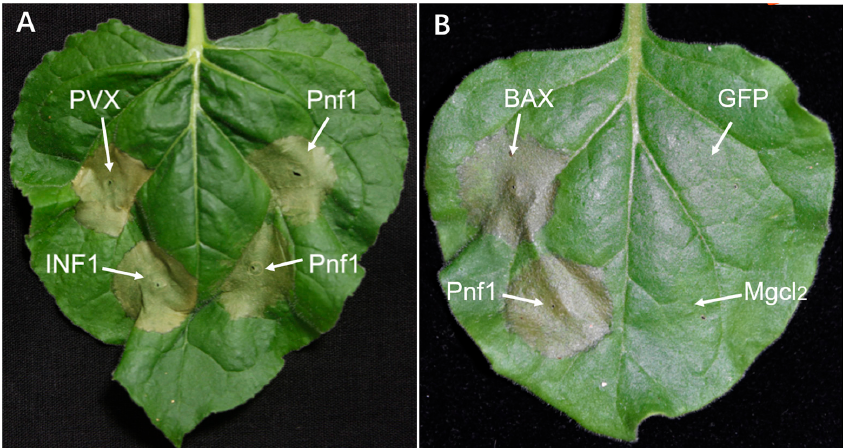
Figure 4. PnF1from Ph. nicotianae JM01 triggers cell death in N. benthamiana leaf. ( A ) The recombinant strains of A. tumefaciens containing PnF1 were infiltrated into N. benthamiana leaf using a needle to detect the function of PnF1. The upper left portion of the leaf in ( A ) is injected with PVX, and the lower left portion of the leaf in ( A ) is injected with INF1. The right portion of the leaf in ( A ) is injected with Pnf1. ( B ) The BCL2-Associated X (BAX) was selected as a positive control, and green fluorescent protein (GFP) and MgCl 2 were selected as negative controls. The upper left portion of the leaf in ( B ) is injected with BAX, and the lower left portion of the leaf in ( B ) is injected with Pnf1. The upper right portion of the leaf in ( B ) is injected with GFP and the lower left portion of the leaf in ( B ) is injected with MgCl 2